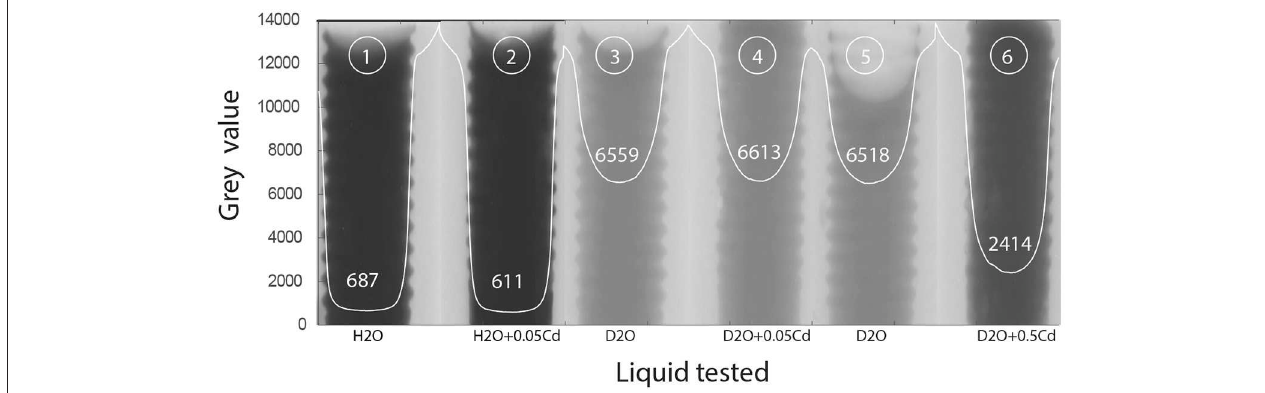
FIGURE 2 | Radiographies and attenuation of injected fluids with, from left to right: (1) H 2 O, (2) solution of H 2 O with 0.05 mol/L cadmium, (3) D 2 O, (4) solution of H 2 O with 0.05 mol/L cadmium, (5) D 2 O, and (6) solution of H 2 O with 0.5 mol/L cadmium. Fluids are placed into 8 mm diameter aluminum crucibles (light gray). Protium based water (1) is attenuating too much and lowers our image projection dynamic range while adding only 0.05 mol/L cadmium to the solution does not give enough contrast (2,4) and falls into the detection method error bar. Hence we ran the experiment with deuterium based water and 0.5 mol/L cadmium concentration (5,6) which are the optimized fluids for the image acquisition of our sample characteristics and optical set-up. TABLE 1 | List of experiments and experimental conditions. Experiment